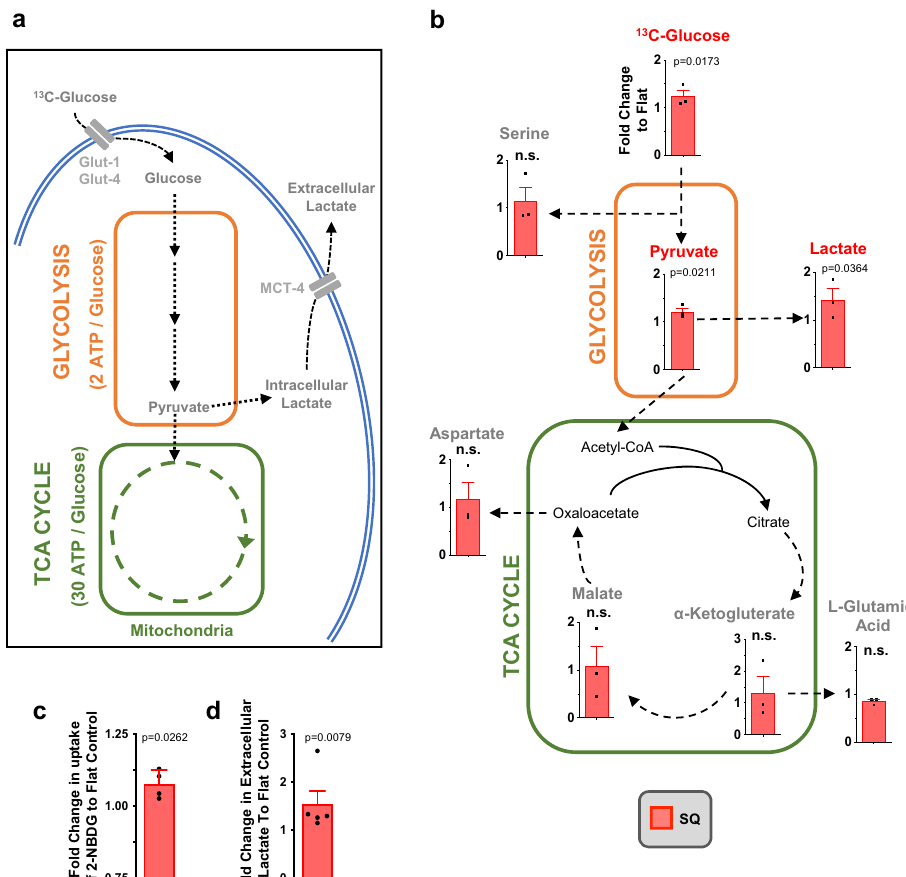
Fig.3|MSCsincreaseoxidativeglycolysisonSQnanotopographies,asrevealed by[ 13 C 6 ]-glucosetracing.a SchematicofMSCrespirationduringculture.Changes to these pathways relative to MSCs on planar controls can be traced using heavy labelled [ 13 C 6 ]-glucose. b Stro-1 + MSCs were cultured for 14 days on nanotopo- graphiesinthepresenceof[ 13 C 6 ]-glucosefor72h.LC-MSwasthenusedtomeasure the conversion and abundance of [ 13 C 6 ]-labelled metabolites in the glycolysis and TCA cycle pathways. Graphs show a fold change in [ 13 C 6 ]-labelled metabolites in MSCs cultured on SQ relative to fl at nanotopographies. c MSCs were cultured for